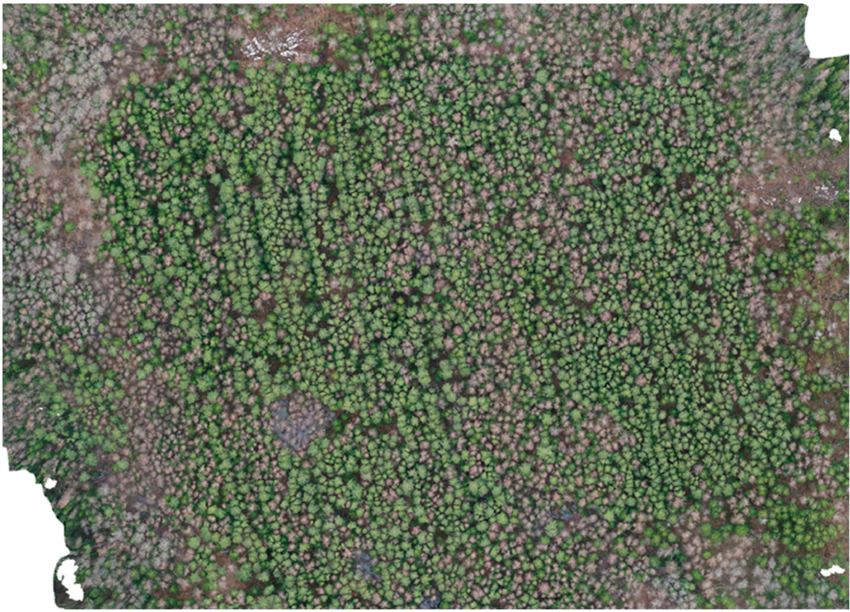
Figure 3. Orthophoto map of the experimental area .